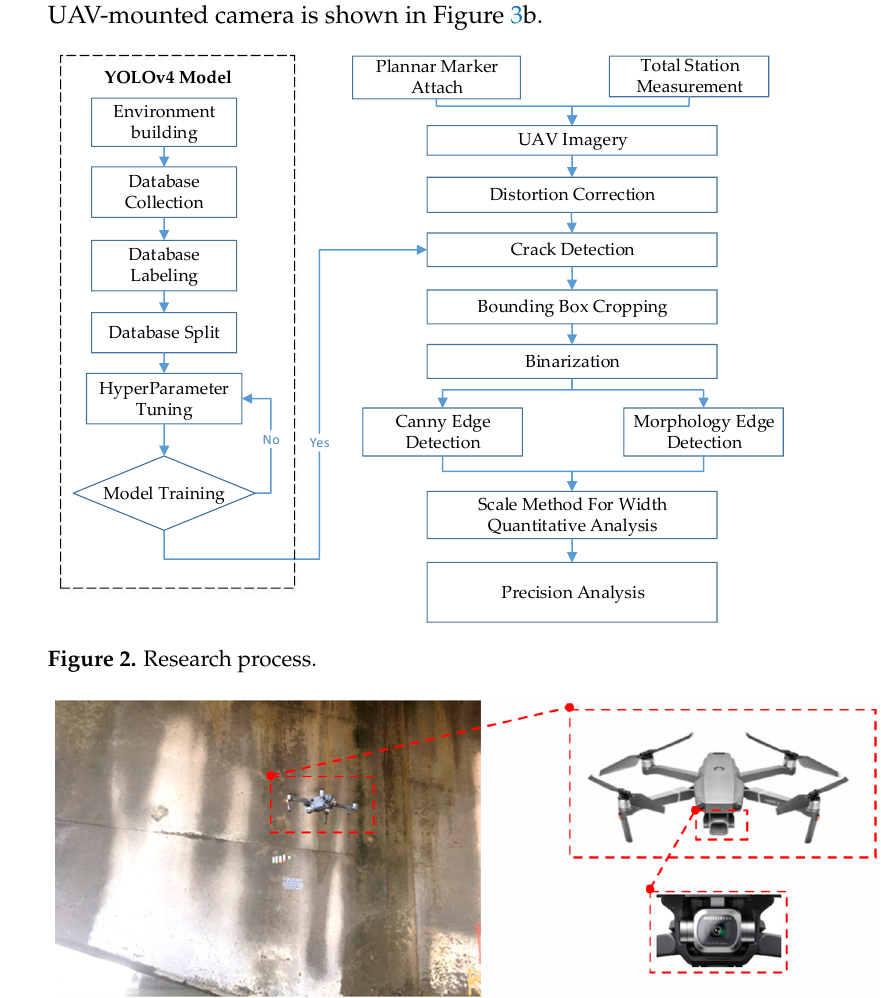
Figure 3. Diagram of the UAV bridge inspection operation.